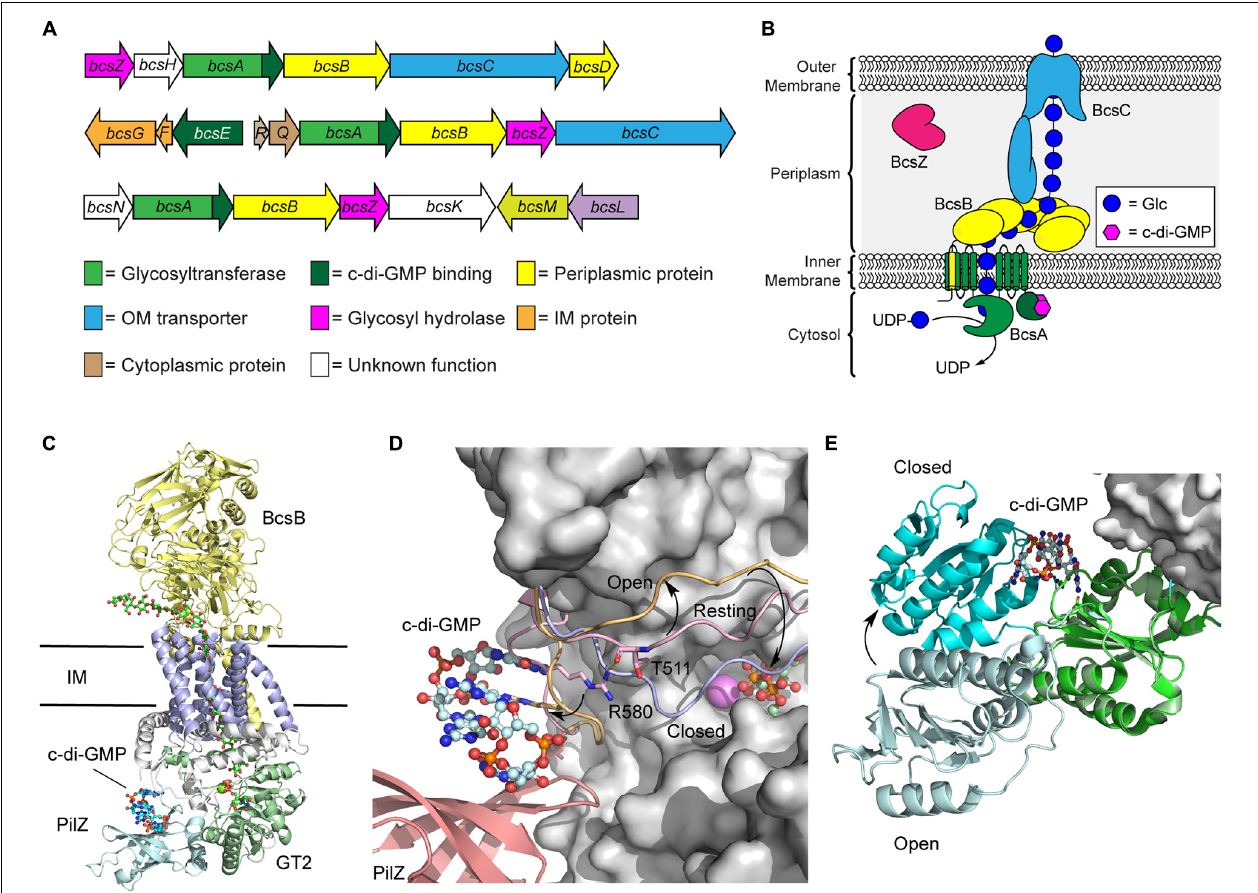
FIGURE 2 | Regulation of the biosynthetic machinery for cellulose biogenesis by c-di-GMP. (A) Representative Bcs operons from K. xylinus (top), E. coli (middle), and Agrobacterium fabrum (bottom) encoding the enzymes required for cellulose biogenesis. (B) Organization of the biosynthetic machinery of the cellulose synthase of K. xylinus . (C) Crystal structure of the BscAB complex of Rhodobacter spharoides bound to c-di-GMP and UDP (PDB id 4P00). BcaB is shown in yellow, the BcsA transmembrane domains, GT2 domain, and PilZ domain are shown in blue, green and cyan, respectively. (D) C-di-GMP binding to the PilZ domain of BcsA results in a conformational change of the “gating loop” allowing access for UDP-Glc to bind to the active site. The conformation of the “gating loop” in the resting (pink, PDB id 4HG6), open c-di-GMP bound (orange, PDB id 4P02) and closed UDP bound (blue, PDB id 4P00) conformations. (E) Structure of BcsE bound to dimeric c-di-GMP and the BcsQR complex (PDB id 6YBB) compared to the structure of BcsE with monomeric c-di-GMP (PDB id 6TJ0). The BcsQR structure is shown as a white surface, the N -proximal domain (cyan) and C -proximal domain (green) of BcsE bound to dimeric